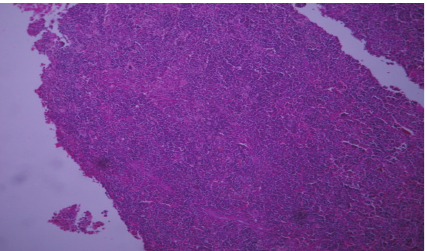
Figure 3: Histology showing normal splenic tissue (low power).